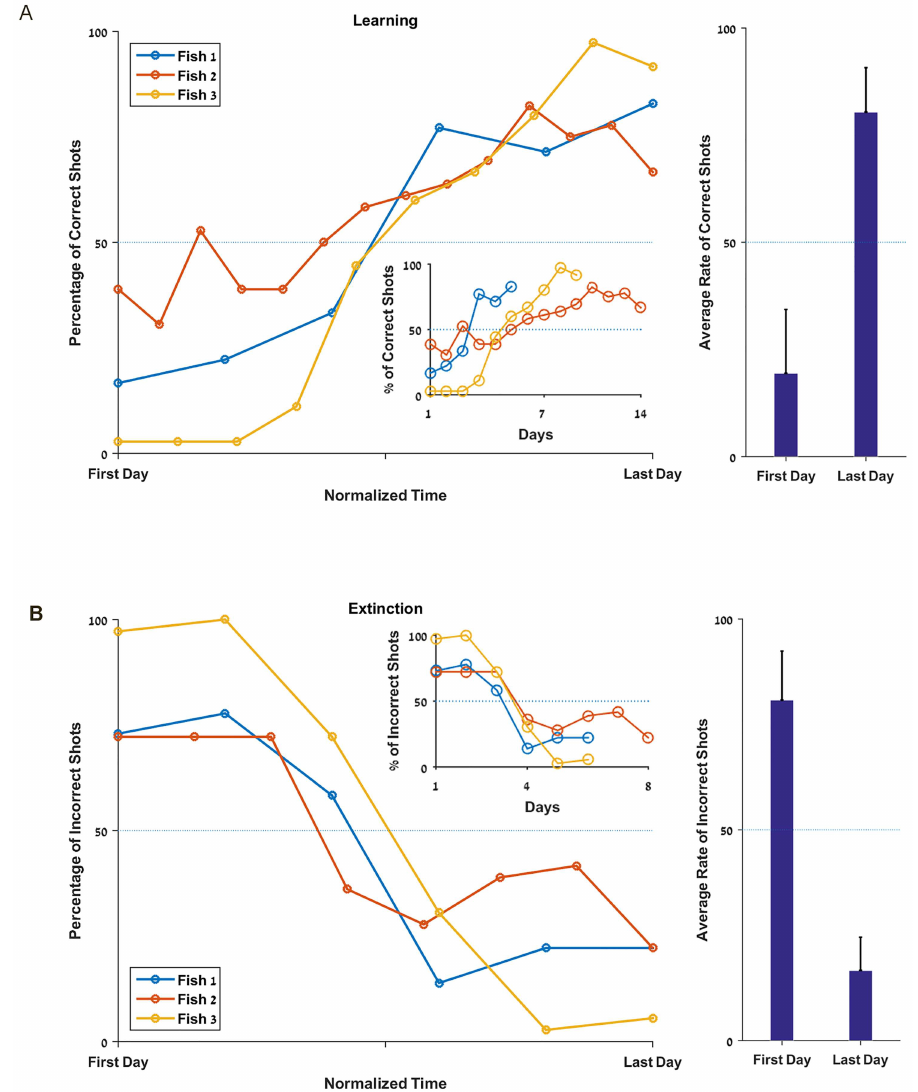
rate of correct shots duringlearningon the first and last days. C. Failure rate for each fish duringthe extinction experiment, with normalized time; the inset shows the same results without normalization. D. Average rate of misses duringextinctionon the first and last days. The dashedline represents the chance level (50%)